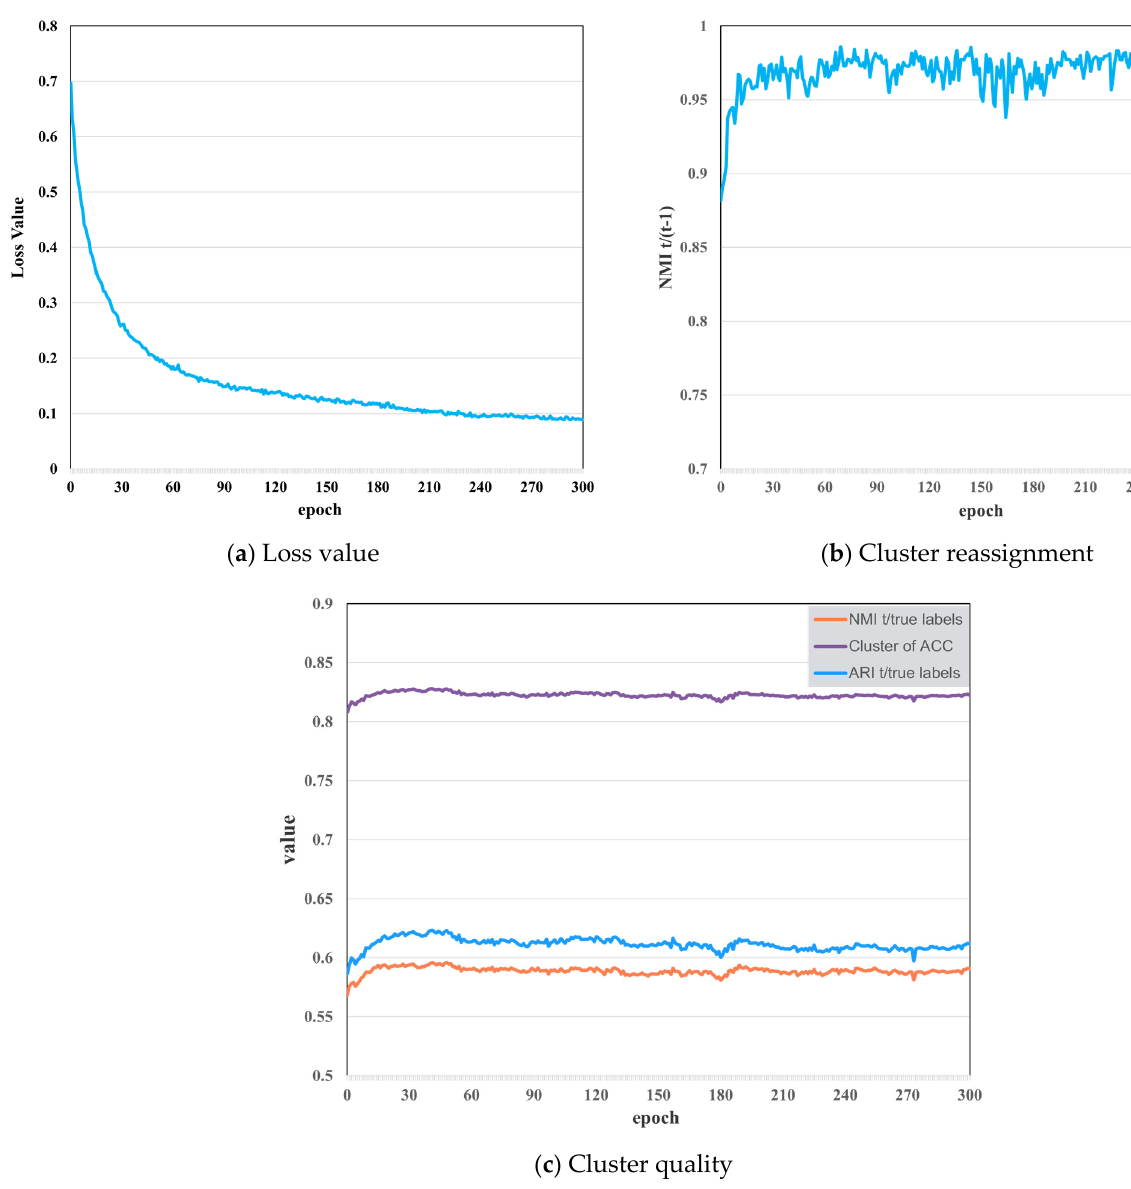
Figure 8. The preliminary studies of the averaged initial cluster centers experiment on the Reunion Island Dataset. ( a ) Loss function; ( b ) cluster reassignment; ( c ) cluster quality.